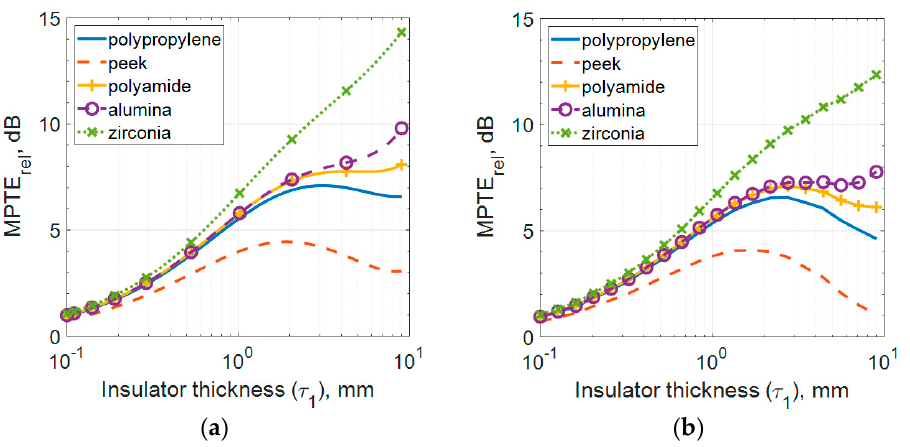
Figure A2. MPTE rel results with commercially available biocompatible materials as an insulating layer at 2.4 GHz: ( a ) Figure 4b; ( b ) results of the off-center Tx model.